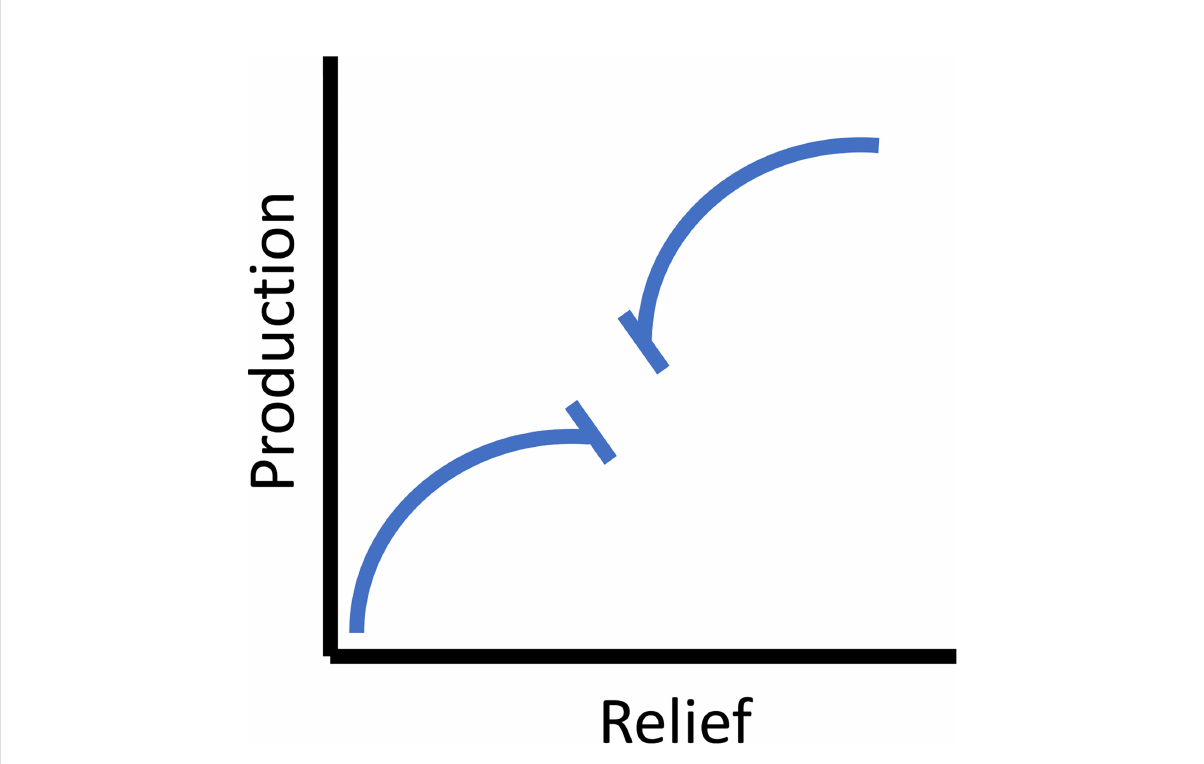
FIGURE 3 The theoretical relationship between vertical relief and secondary ( fi sh) production. For the scale of typical reefs (meters) the relationship asymptotes (left side on x-axis), and then for very high relief reefs (10 ’ s of meters) and those that include an intertidal component (e.g., breakwaters, some shipwrecks, and oil platforms) the relationship is extended until it asymptotes again (right side on